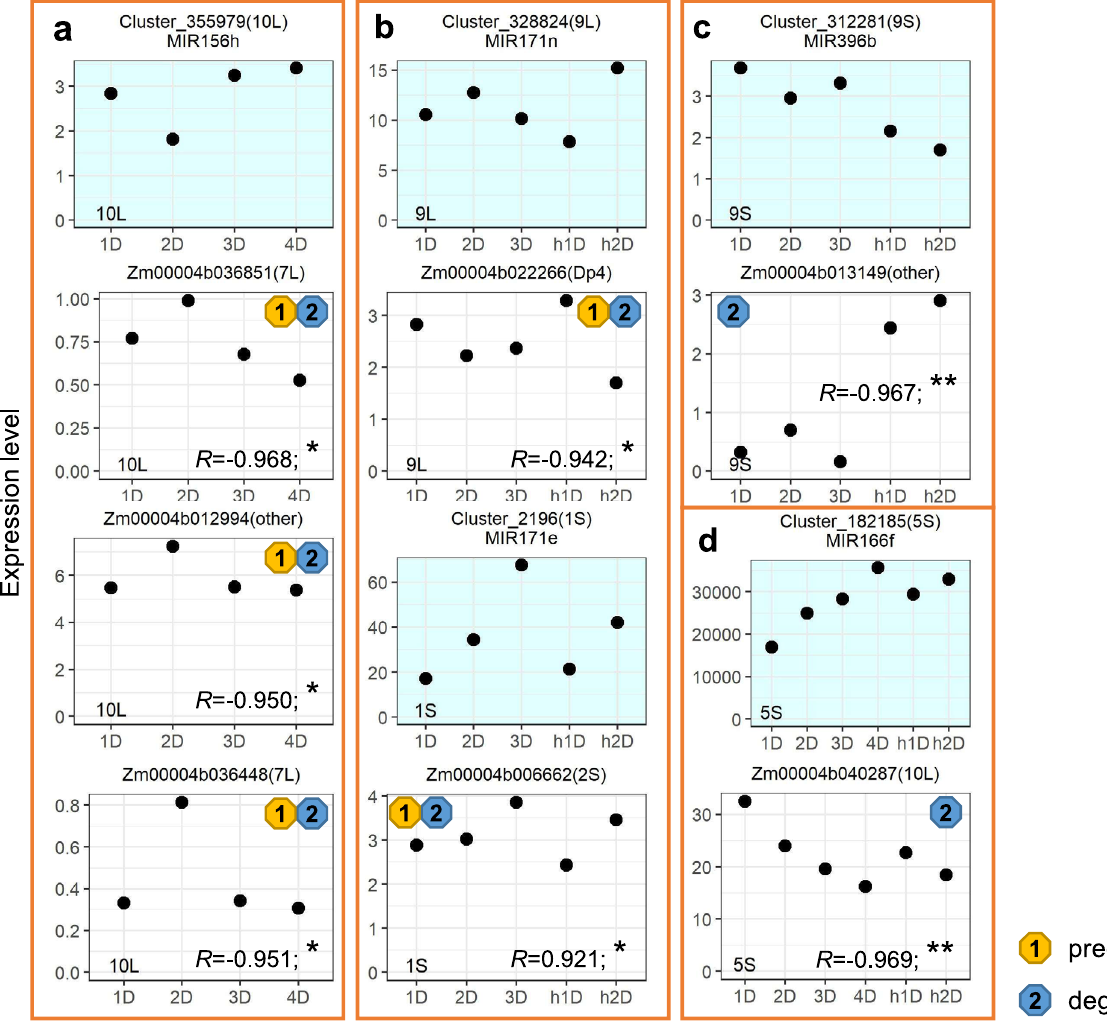
Fig. 10 Expression levels of cis MIRNAs and their trans targets. The cis location of each MIRNA or each target is depicted within parentheses. “ Other ” refers to genes that do not fall in the cis region of any B – A translocation line. The x-axis refers to the dosage of the chromosomal region as noted in the bottom-left corner of each panel, whereas the y-axis designates the expression level (rpm) of each MIRNA in cis or each target in trans (normalized read counts) corresponding to the genotype on the x-axis. Correlations between cis MIRNAs (blue background panel) and their targets (white background panel below each MIRNA ) were predicted by psRNATarget (yellow circled 1) or gathered from degradome sequencing data from other studies (blue circled 2). R Pearson correlation coef fi cient between expression levels of MIRNA and its corresponding target. P values for Pearson correlation (two-sided; con fi dence intervals, 95%; no adjustment made for multiple comparisons): * P value < 0.05; ** P value < 0.01 (exact P values shown in Supplementary Data 7,